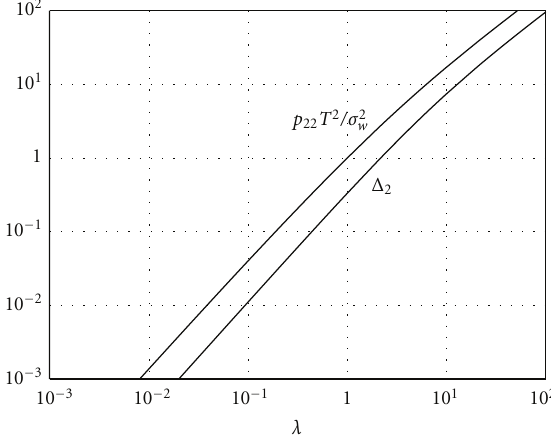
Figure 4: Noise ratios Δ 2 and p 22 T 2 /σ 2 w as functions of λ